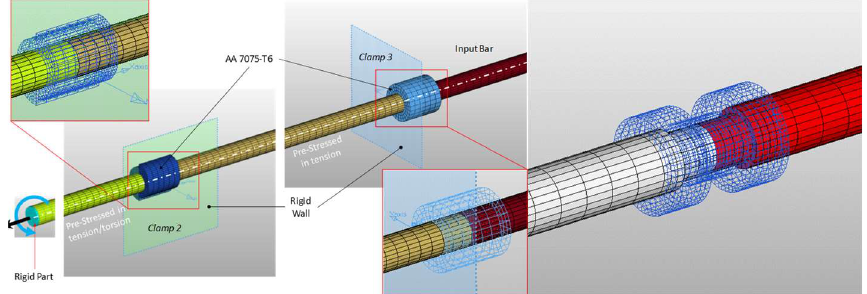
Fig. 5. FEM model of the SHTT bar